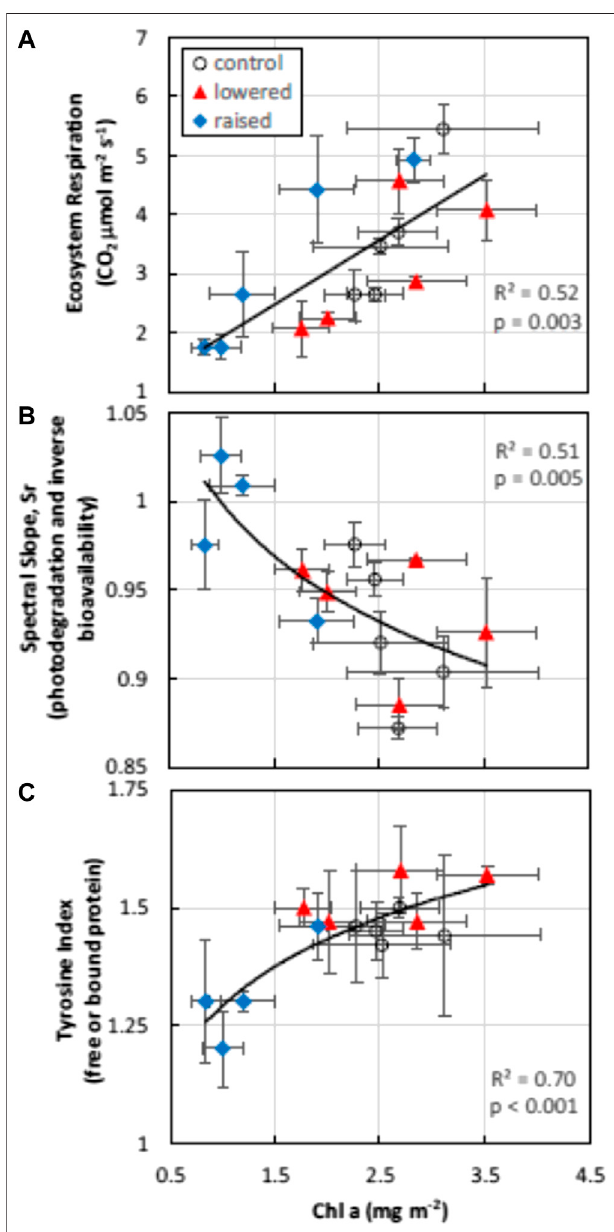
FIGURE3| Algalbiomass (chlorophyll acontent)wasstrongly related to changesinecosystemrespiration(toppane)measuredwith fl oatingchambers during fl ooding, the bioavailability of DOM (inversely related to spectral slope ratio, Sr, middle pane) and the content of free or bound protein (TI, bottom pane). Depicted are daily means by water table treatment plot in the fl ooded year (2018). Error bars represent standard errors of the mean values.